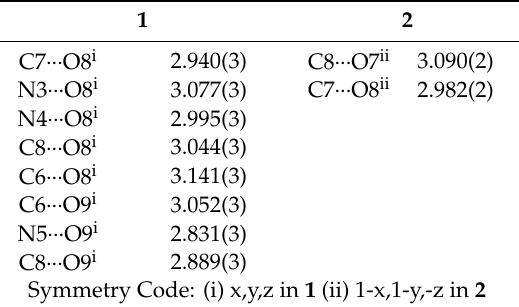
Table 4. Anion– π contacts in complexes 1 and 2